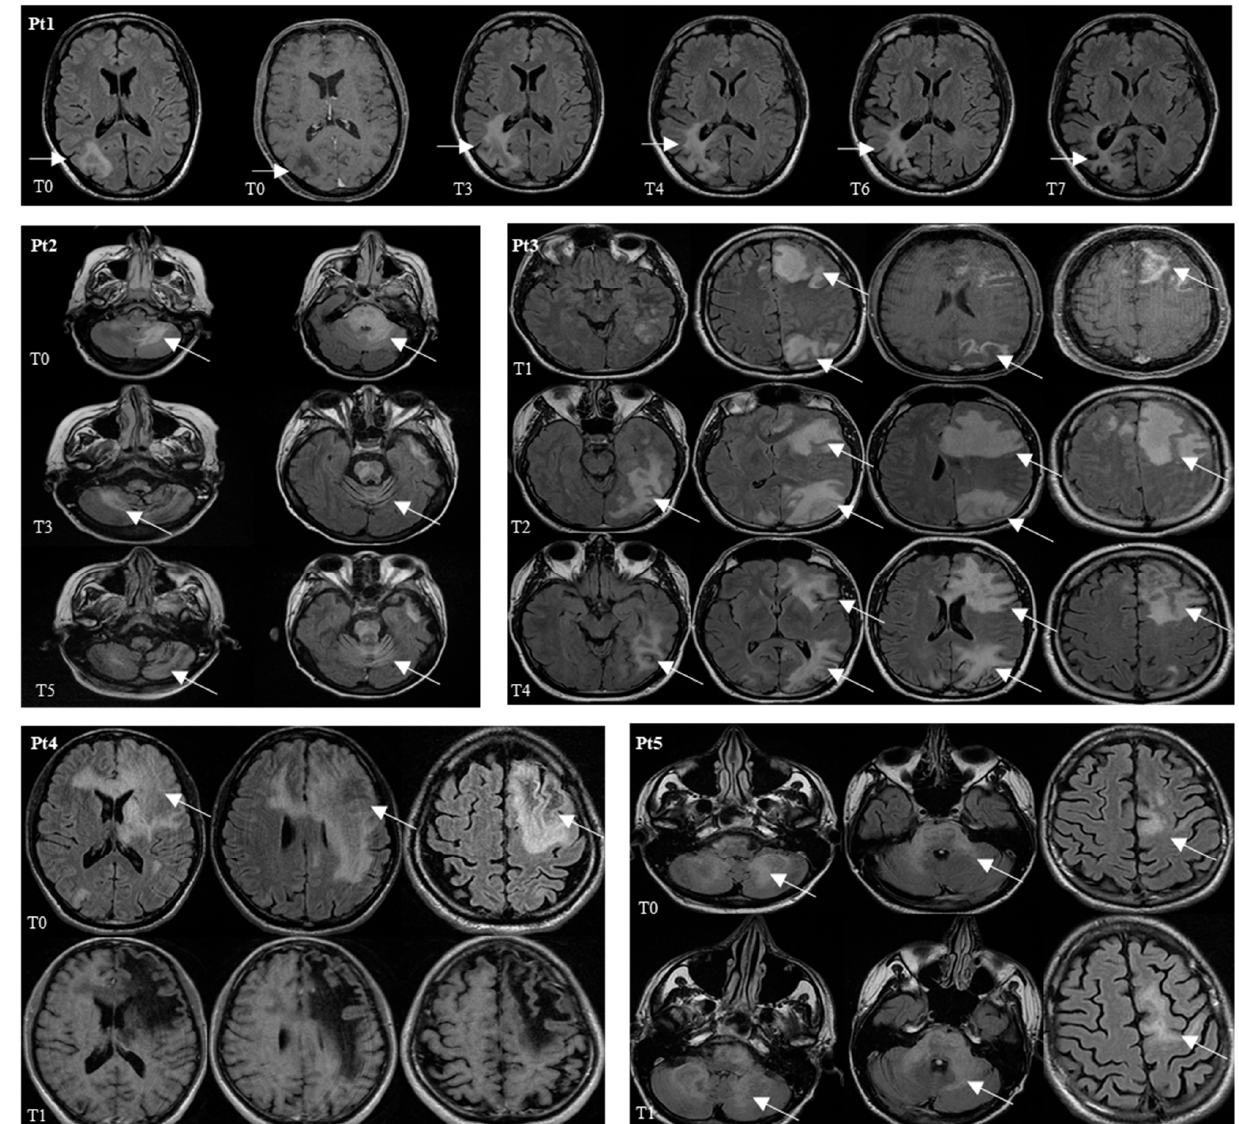
Figure 2. MRI axial T2 Flair of alive Patients (Pt1, Pt2, Pt3) and dead Patients (Pt4 and Pt5) at different timepoints. Pt 1: hyperintensity of white matter in the right parietal region. Pt 2: hyperintensity in the cerebellar hemispheres, brainstem and left temporal pole. Pt 3: hyperintensity in the left frontal and parietal lobe. Pt 4: hyperintensity in white and grey matter of bilateral frontal lobes and genu of corpus callosum. Pt 5: diffuse hyperintensity in cerebellar hemispheres and brainstem. Hyperintensity of white and grey matter of mesial portion of left frontal lobe. In three alive patients the neuroradiological findings showed well-defined inflammatory white matter localizations, including multiple districts. In follow up studies, lesions decreased causing response to therapy. In two dead patients the lesions appeared too extensive with multiple localizations and direct extension into the controlateral hemisphere through corpus callosum fibers and brainstem. In follow up MRI studies, no reductions in lesions extent were